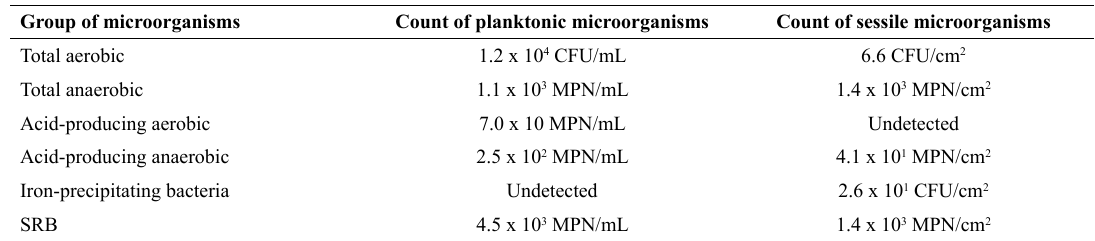
Table 2. Quantification of the planktonic microorganisms present in the produced water and sessile adhered to the film after 360 days. Group of microorganisms Count of planktonic